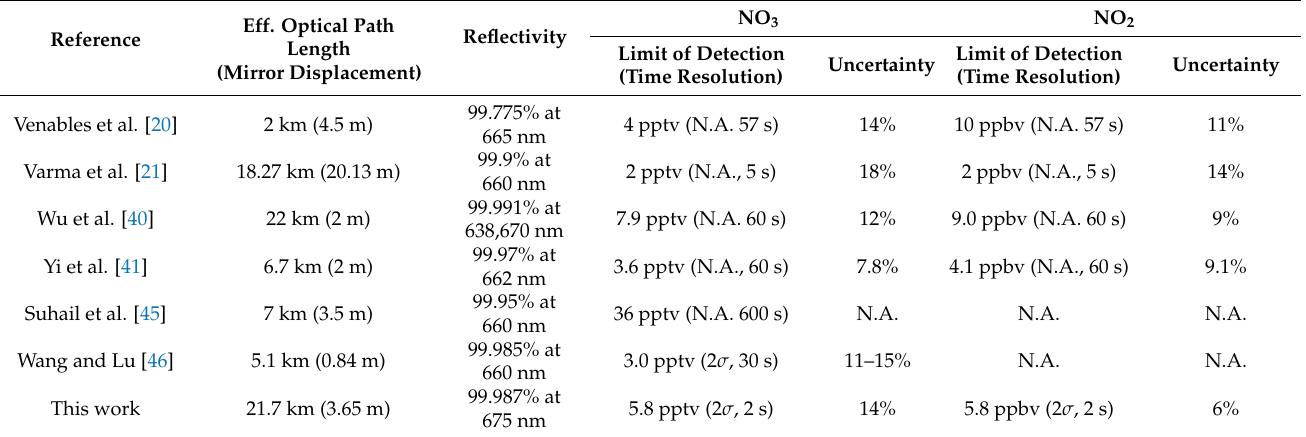
Table 1. Comparison of OP-IBBCEAS performances for NO 3 and NO 2 measurement under ideal